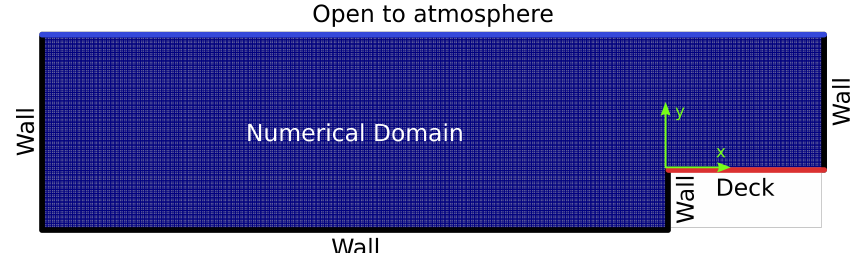
Figure 4. Numerical domain for the dam-break